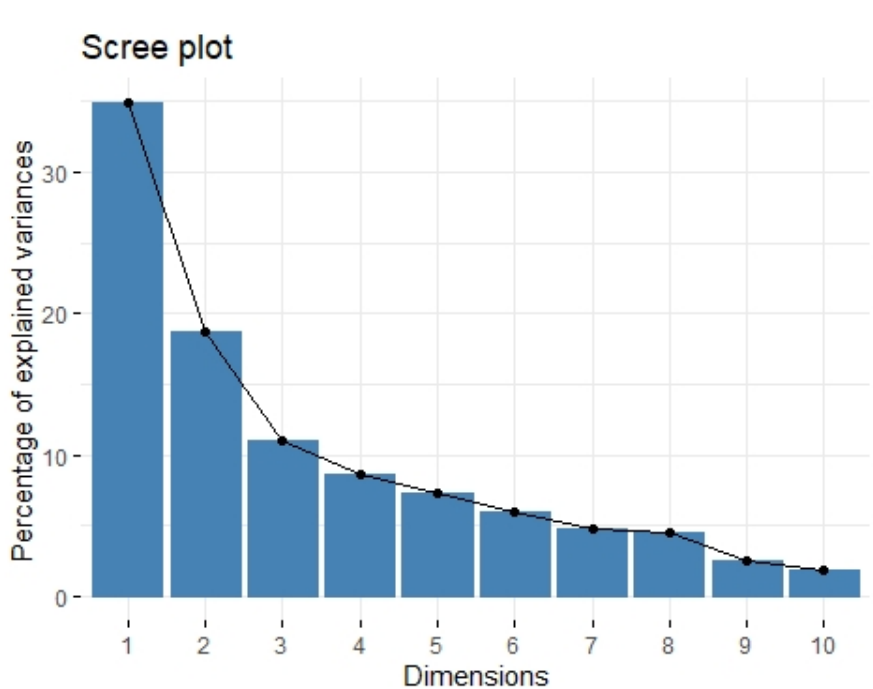
Figure 4. Scree plot of principal component analysis containing protumor growth factors (HGF, M-CSF, b-NGF, SCGF-b, IL-7, FGFbasic, G-CSF, PDGF-bb, VEGF, GM-CSF). Scree plot shows the proportion of overall variance explained by each individual principal component (factor).